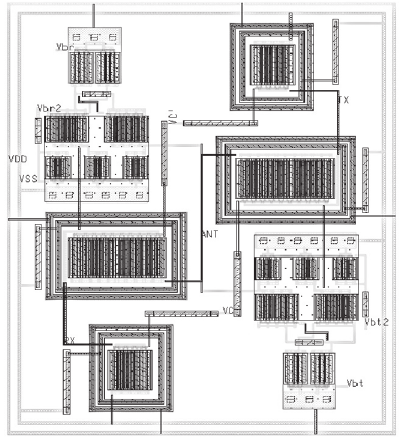
Figure 10 - Core layout design of the proposed switch with area 0.003mm 2 .